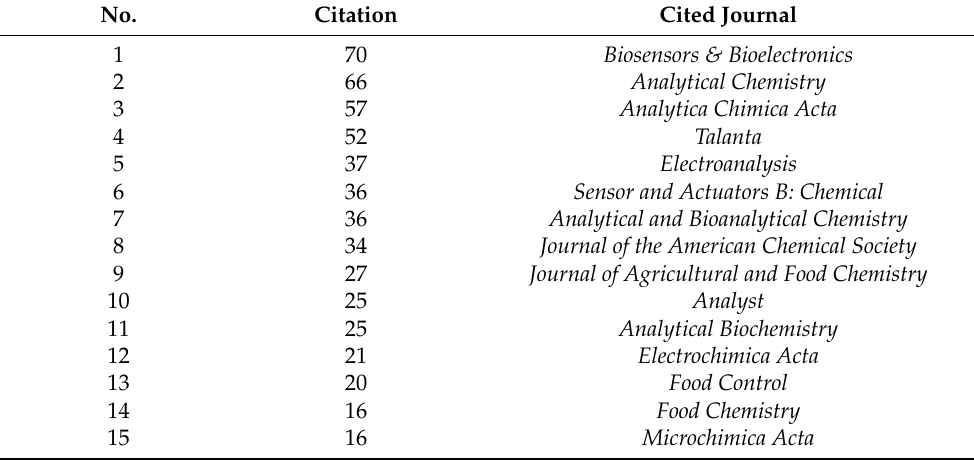
Table 1. Top 15 cited journals on the electrochemical techniques for the detection and analysis of GM crops.